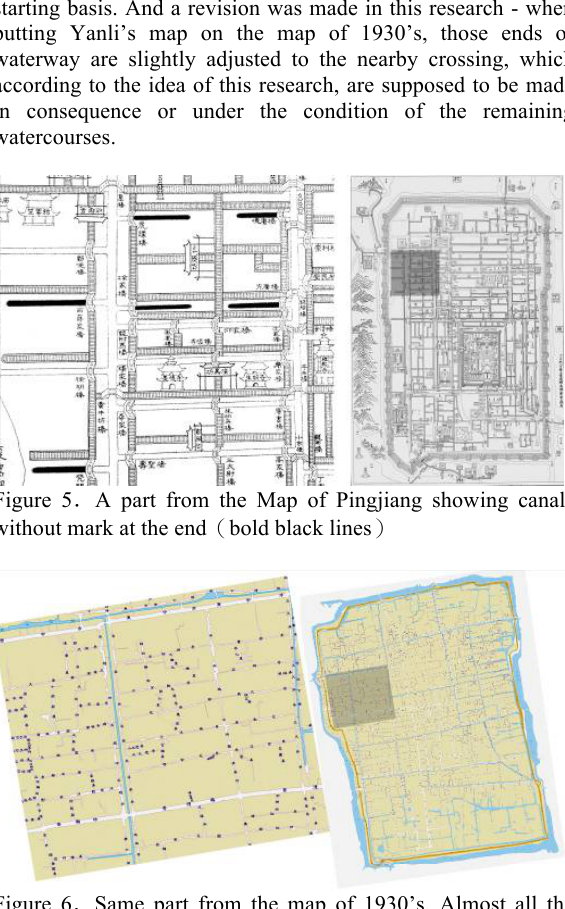
Figure 6 ． Same part from the map of 1930’s. Almost all the canals lost. But those alleys became hint of the ends of those ever-existing